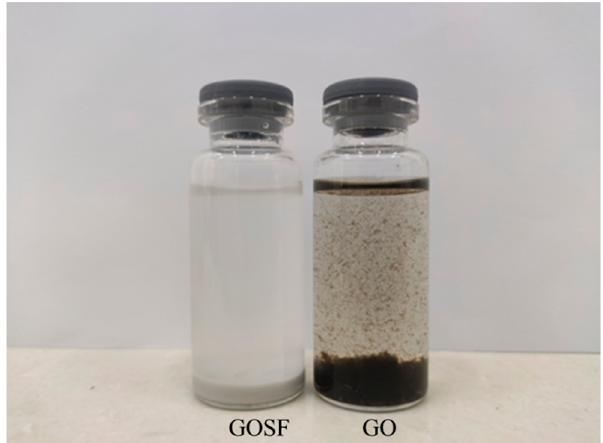
Figure 7. Dispersion stability of GO and GOSF in CH saturated solution.